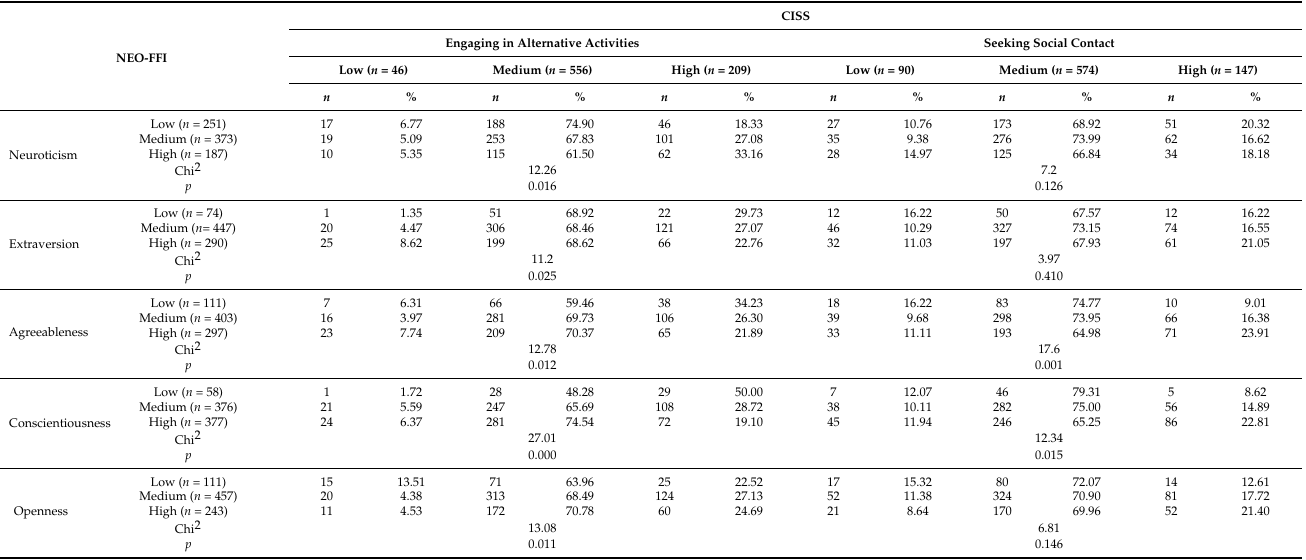
Table 6. The relationship between personality traits according to the NEO-FFI Questionnaire and styles of coping with stress according to the CISS Questionnaire (part two).